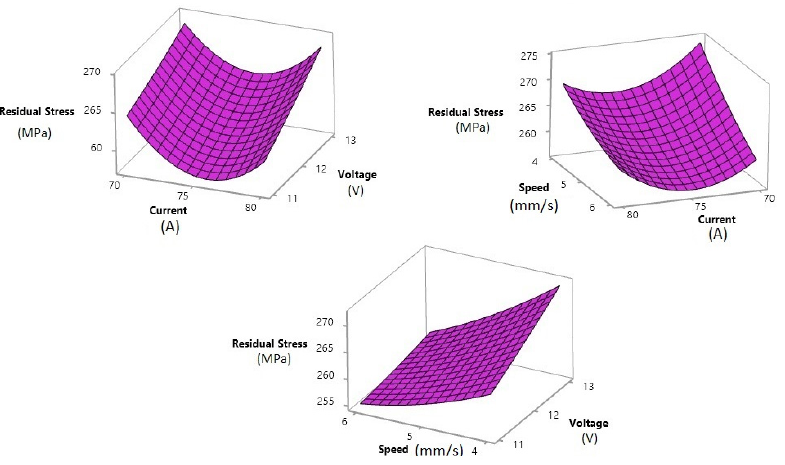
Figure 7. The surface plot of the distortion vs. welding current, voltage, and speed .